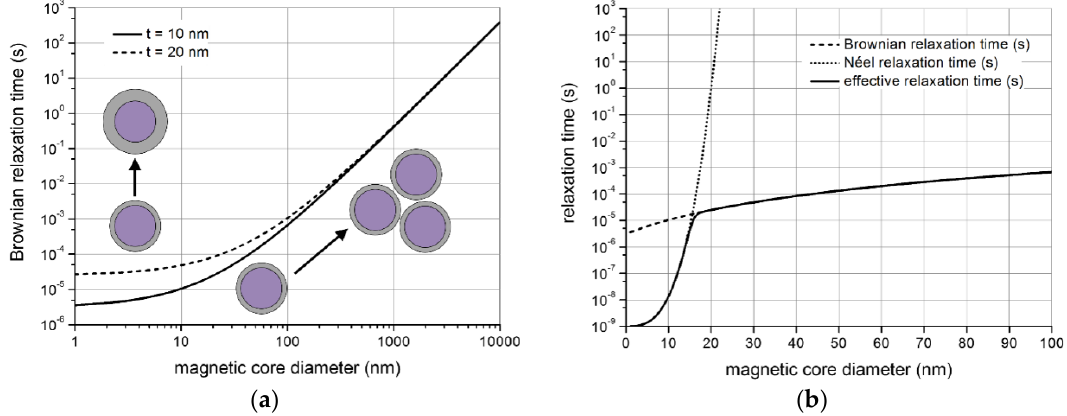
Figure 3. Brownian, Néel and effective relaxation time in dependence of the particle volume. A spherical magnetite particle with a magnetic core (purple area) encapsulated by a hydrodynamic shell (grey area) of thickness t is assumed: ( a ) Brownian relaxation time in dependence of the magnetic particle core diameter for hydrodynamic shell thicknesses of 10 nm (solid line) and 20 nm (dashed line). While an increase of the hydrodynamic shell thickness affects the Brownian relaxation time of small particles at short relaxation times, particle clustering induces large changes of the relaxation time less dependent of the initial particle size; ( b ) Brownian, Néel and effective relaxation time as functions of the magnetic core diameter [112].